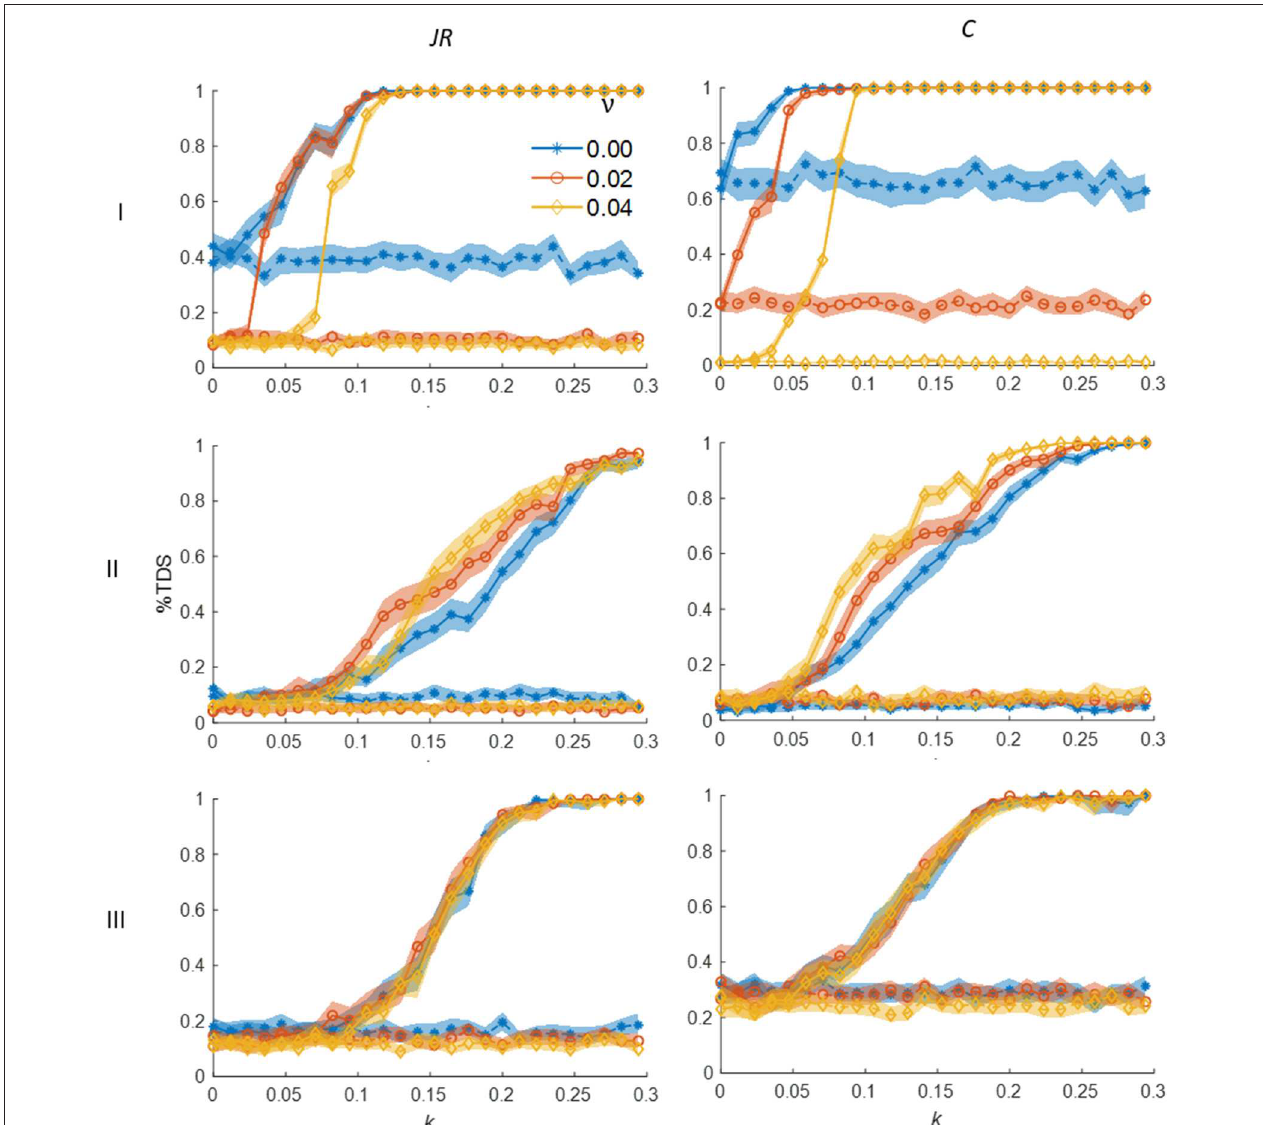
FIGURE 2 | Mean values of %TDS results from analyses of Rössler systems as a function of phase-regimes, coupling strength k , and detuning factor, ν for JRQA-based ( JR ; left column) and cross-correlation-based analyses ( C ; right column). Row I : Two phase-coherent Rössler systems. Row II : One phase-coherent and one funnel regime system. Row III : Two funnel regime systems. For all figures, dashed lines (usually lower) indicate %TDS for uncoupled systems and the solid lines (usually higher) mark %TDS for systems after coupling is established. The shaded regions correspond to 95% confidence intervals obtained via a bias-corrected percentile bootstrap with 500